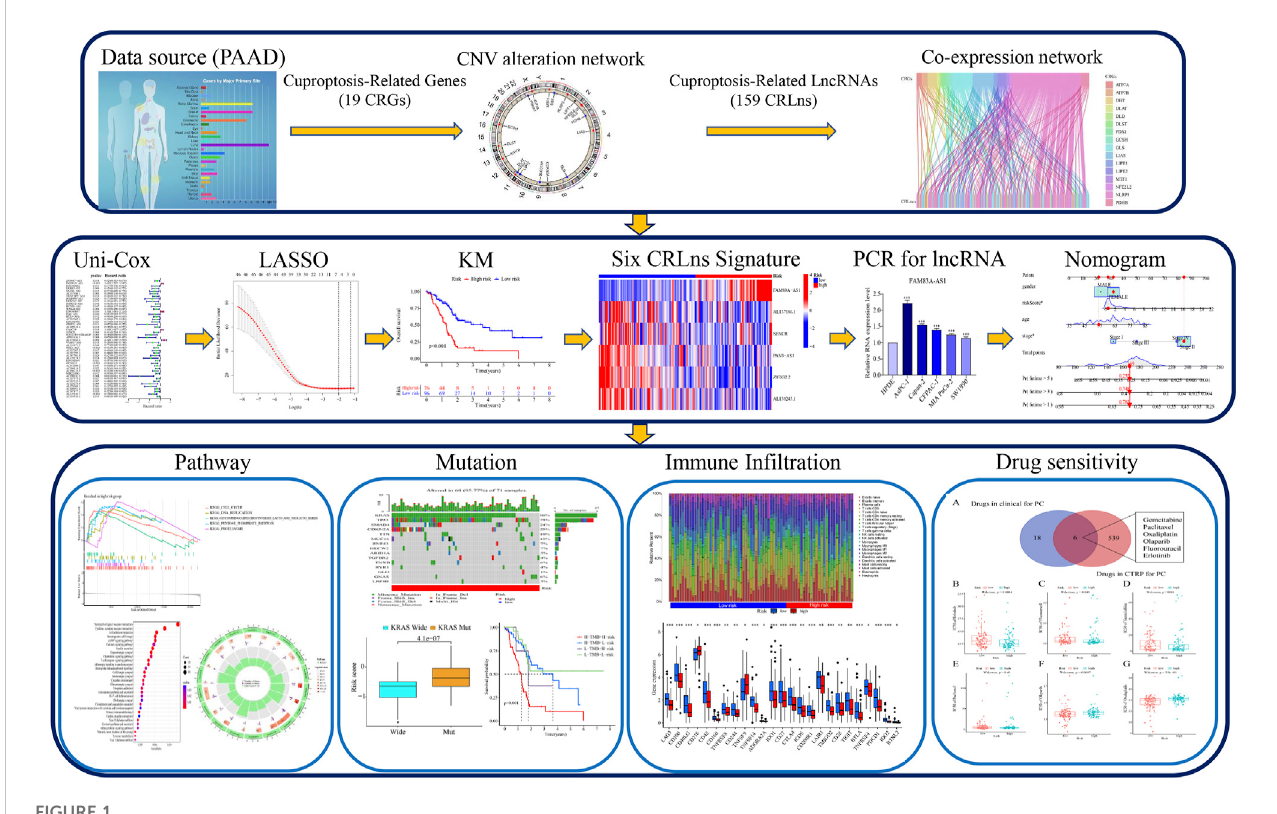
FIGURE 1 The fl owchart for analyzing cuproptosis-related lncRNAs prognostic